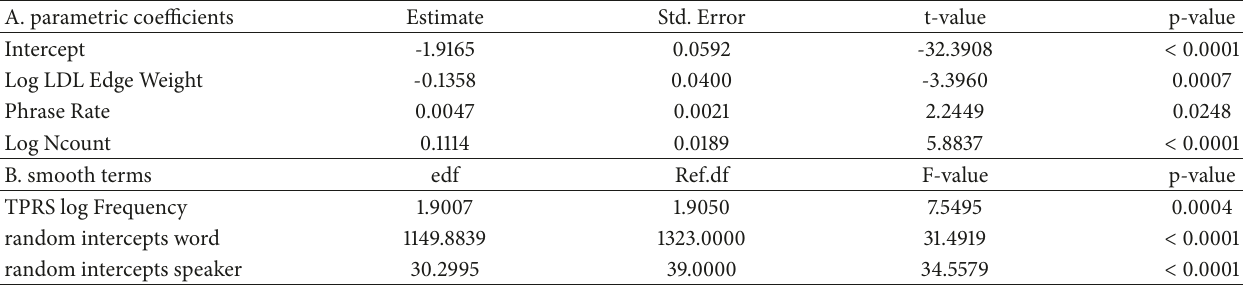
Table 7: Statistics for the partial effects of a generalized additive mixed model fitted to the relative duration of edge segments in the Buckeye corpus. The trend for log frequency is positive accelerating. TPRS: thin plate regression